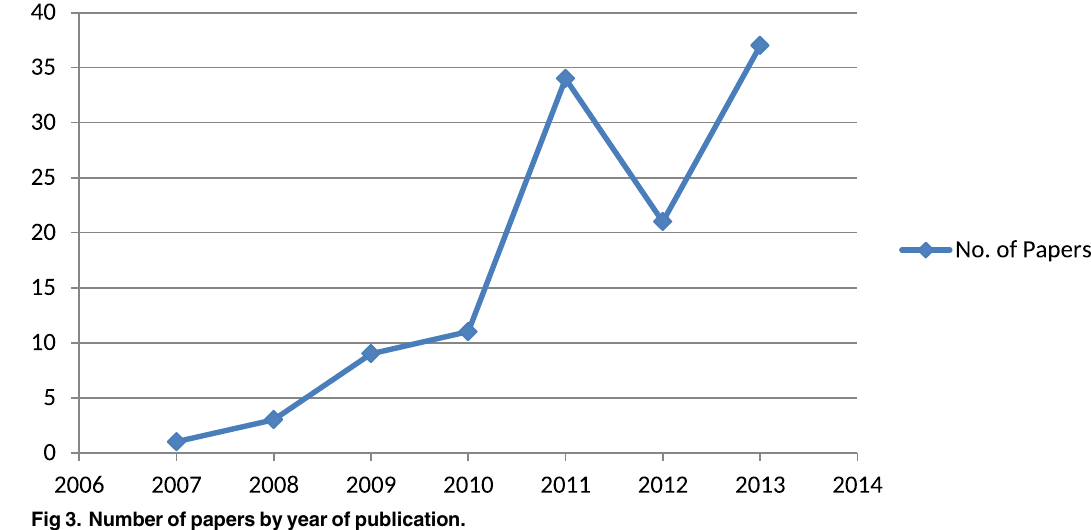
Fig 3. Number of papers by year of